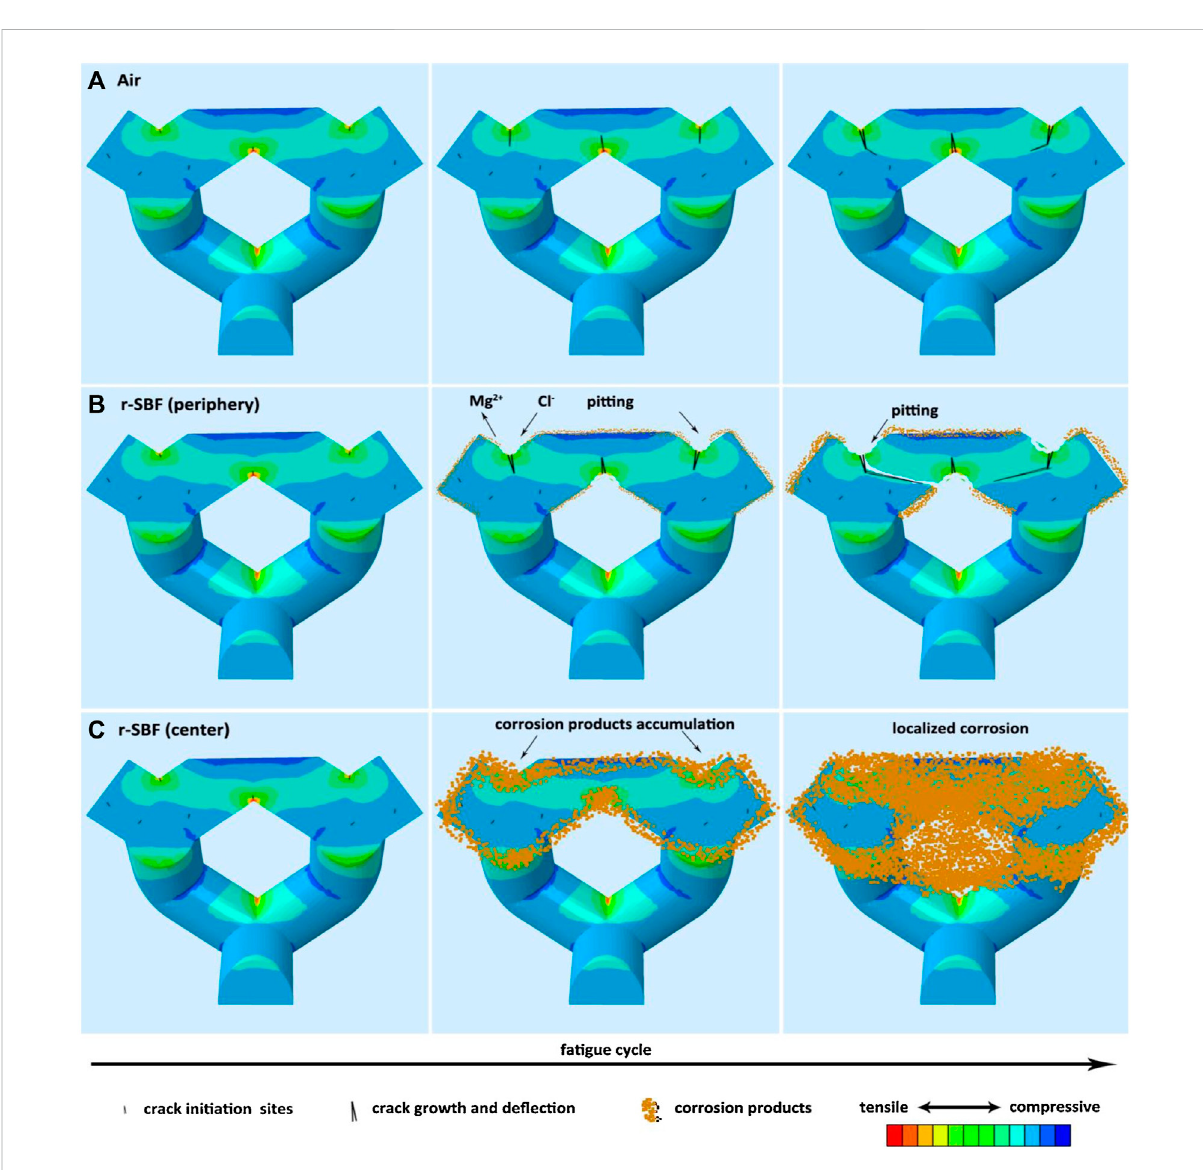
FIGURE 6 SchematicillustrationofthefatiguemechanismofAMMgalloyscaffolds(Lietal.,2019b). (A) Inair, (B) inr-SBFontheperiphery,and (C) inr-SBF at the